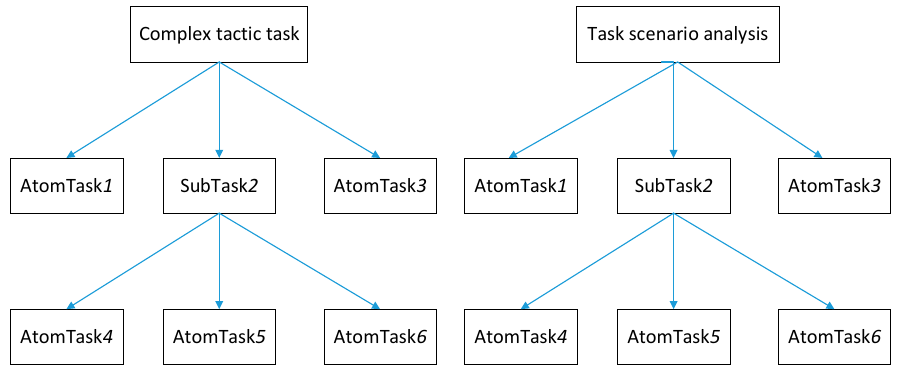
Figure 1. The hierarchical structure and corresponding relationship of tasks and scenarios.